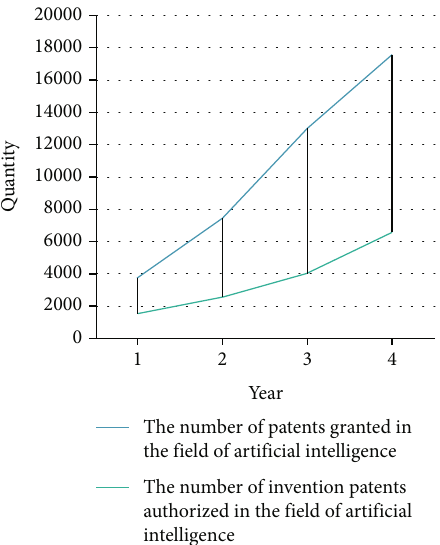
Figure 3: Data map of the Chinese patent.